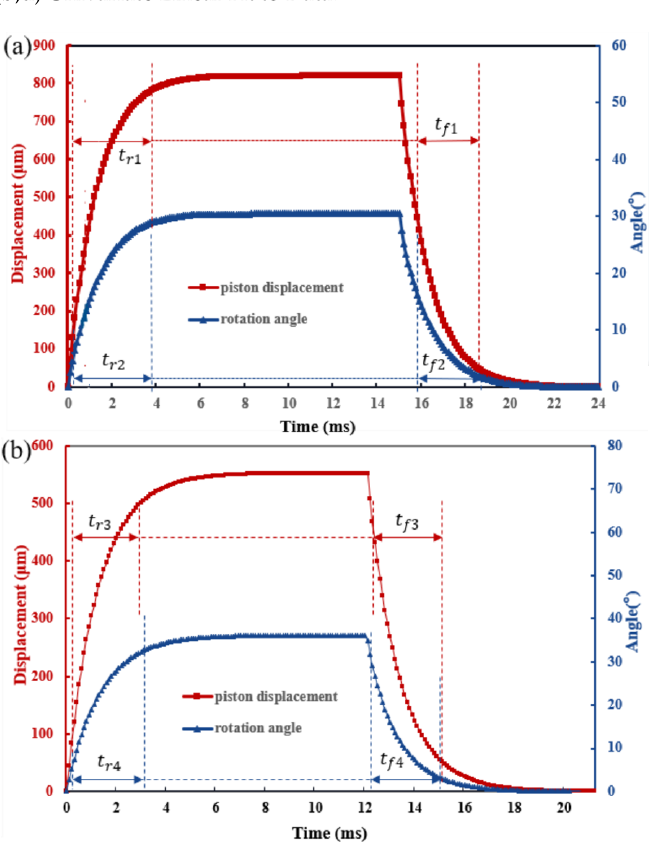
Figure 8. The transient curves. ( a ) “ O ” type. t r1 = 3.7 ms, t r2 = 3.6 ms, t f1 = 2.8 ms, t f2 = 3 ms. ( b ) “ Z ” type. t r 3 = 2.9 ms, t r 4 = 2.7 ms, t f 3 = 2.8 ms, t f 4 = 3 ms. type. t r 3 = 2.9 ms, t r 4 = 2.7 ms, t f 3 = 2.8 ms, t f 4 = 3